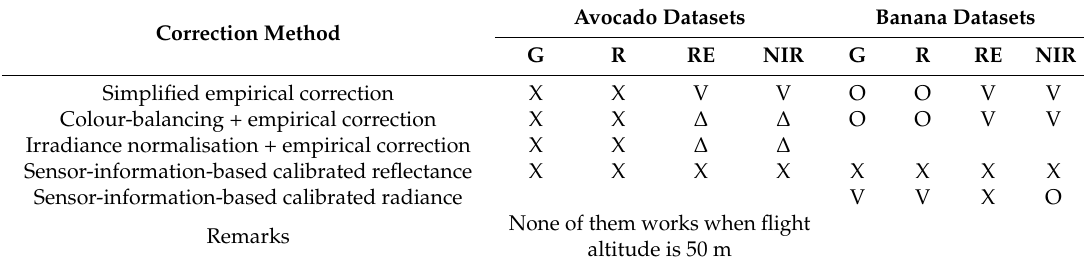
Table 3. A simplified comparison table of the proposed correction methods. G, R, RE, and NIR are green, red, red edge, and NIR bands respectively. X means the method doesn’t work well; V means the method works well; ∆ means the results are unstable; O means the results are moderately consistent. Avocado Correction Method